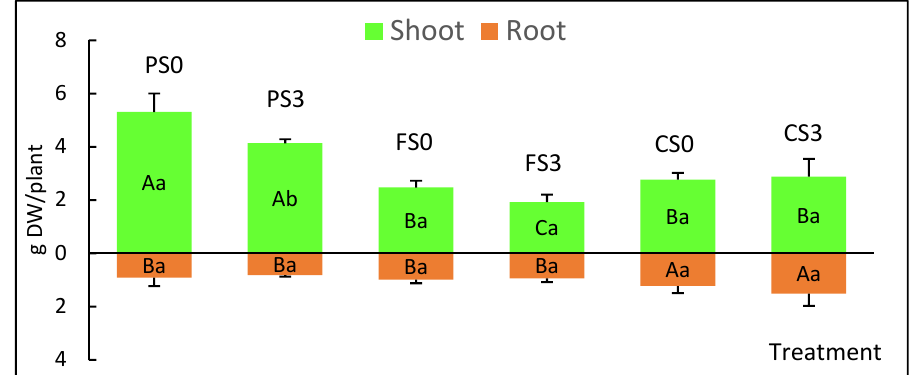
Figure 8. Aerial and root biomass of willow plantlets cultured for 4 weeks in the phytotron and 6 weeks in the greenhouse in three types of soil. PS0, PS3: plants grown in peat and micropropagat- ed without sucrose (PS0) or with 3% sucrose (PS3); FS0, FS3: plants grown in a forest soil and micropropagated without sucrose (FS0) or with 3% sucrose (FS3); CS0, CS3: plants grown in a crop soil and micropropagated without sucrose (CS0) or with 3% sucrose (CS3). Values are presented as means ± standard error of four plants per treatment. For each variable, different uppercase letters indicate significant differences in relation to the soil, and different lowercase letters indicate significant differences relative to the sucrose supplementation ( p < 0.05). Due to the significant interaction found in aerial growth, Bonferroni’s adjustment was applied to detect simple main effects. Photosynthetic pigments (chlorophylls a and b and total carotenoids) of plantlets af- ter acclimation at 6 weeks are shown in Figure 9, and the two-way ANOVA results are presented in Table S7.